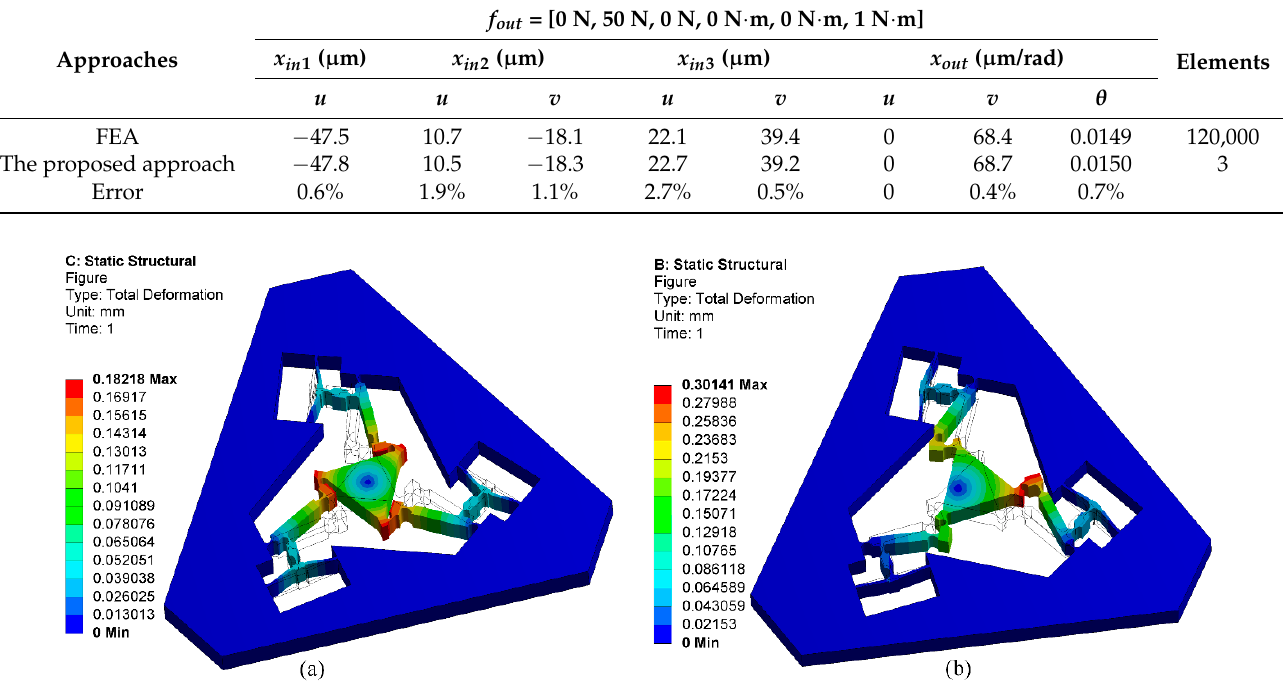
Figure 15. Finite element results. ( a ) f in 1 = f in 2 = f in3 = 100 N; ( b ) f out = [0 N, 50 N, 0 N, 0 N·m, 0 N·m, 1 N·m].